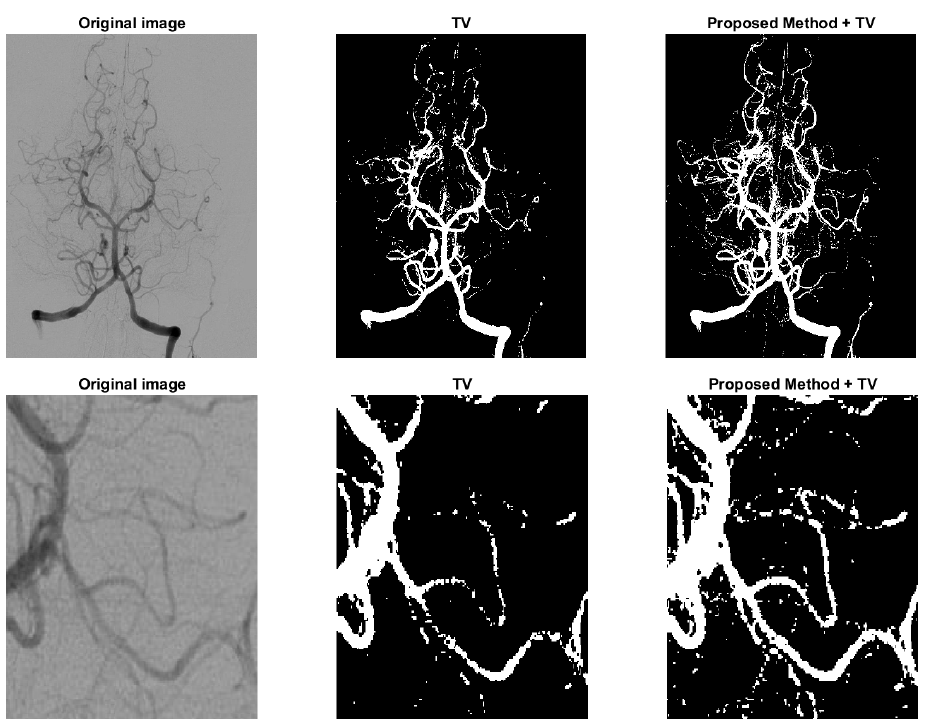
Figure 9. Another example to show the effect of the proposed regularization on unsupervised model. Column 2: the model in [5] with TV regularization only. Column 3: the proposed model